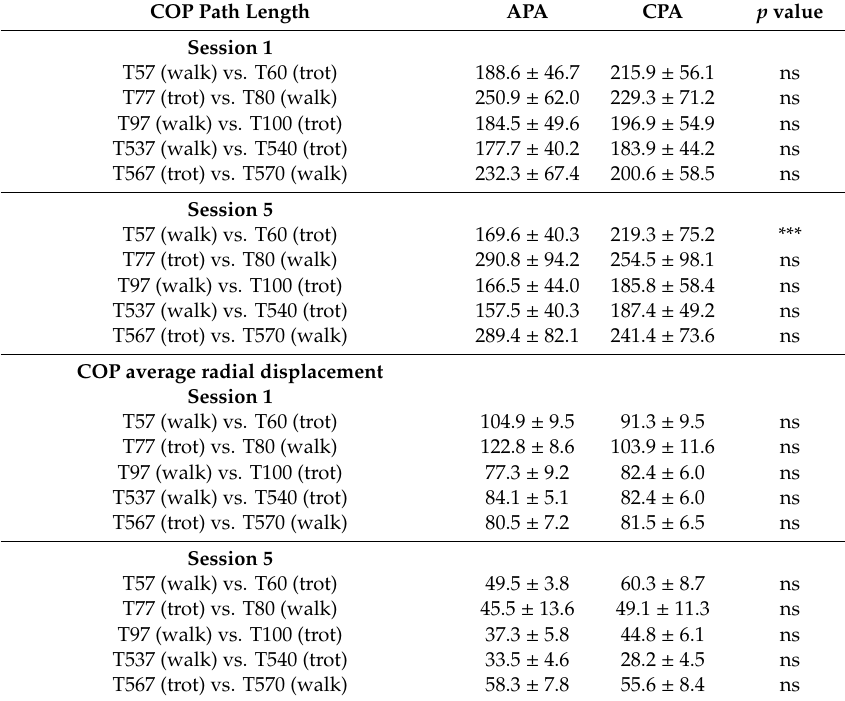
Table 6. Comparison of compensatory postural adjustment (CPA) versus anticipatory postural adjustment (APA) for the two measured variables (COP path length and COP ARD) during pace changes. D1 corresponds to session 1 and D5 to session 5. Values correspond to means ± SD of the mean. p < 0.001 (***).